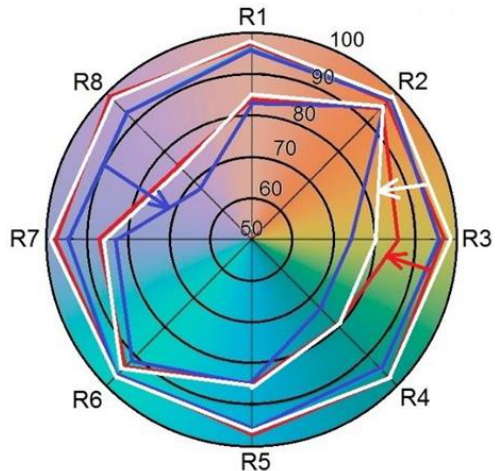
Figure 4. The specific color rendering index R i of the light filtered through the EC devices for each test color. The blue, white, and red lines refer to the sol – gel/dip-coated, sol – gel/spin-coated, and r.f. sputtered devices, respectively.